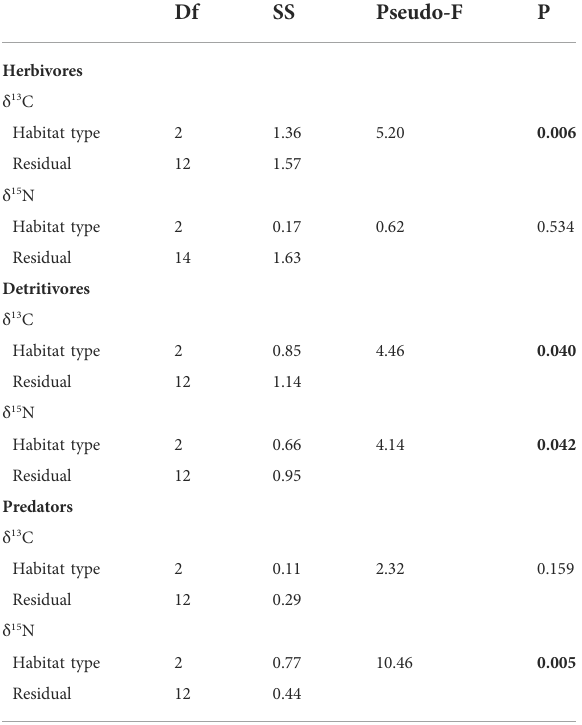
TABLE 3 Results from one-way PERMANOVA of absolute differences in δ 13 C and δ 15 N values for three trophic groups among reference and restored (mound or terrace) habitat types. p -values less than 0.05 are indicated in bold